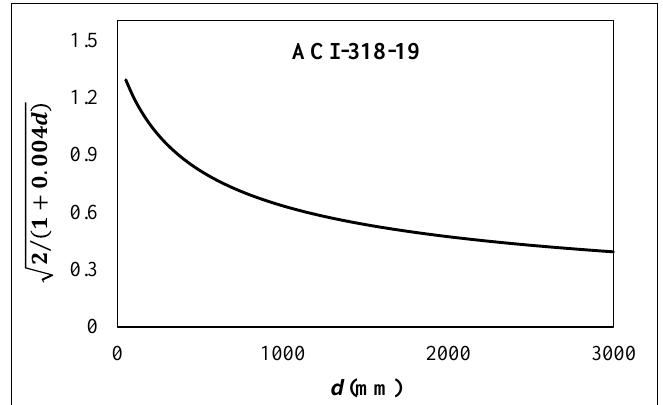
Figure 2. Reducing terms evolution according to increasing beam size.